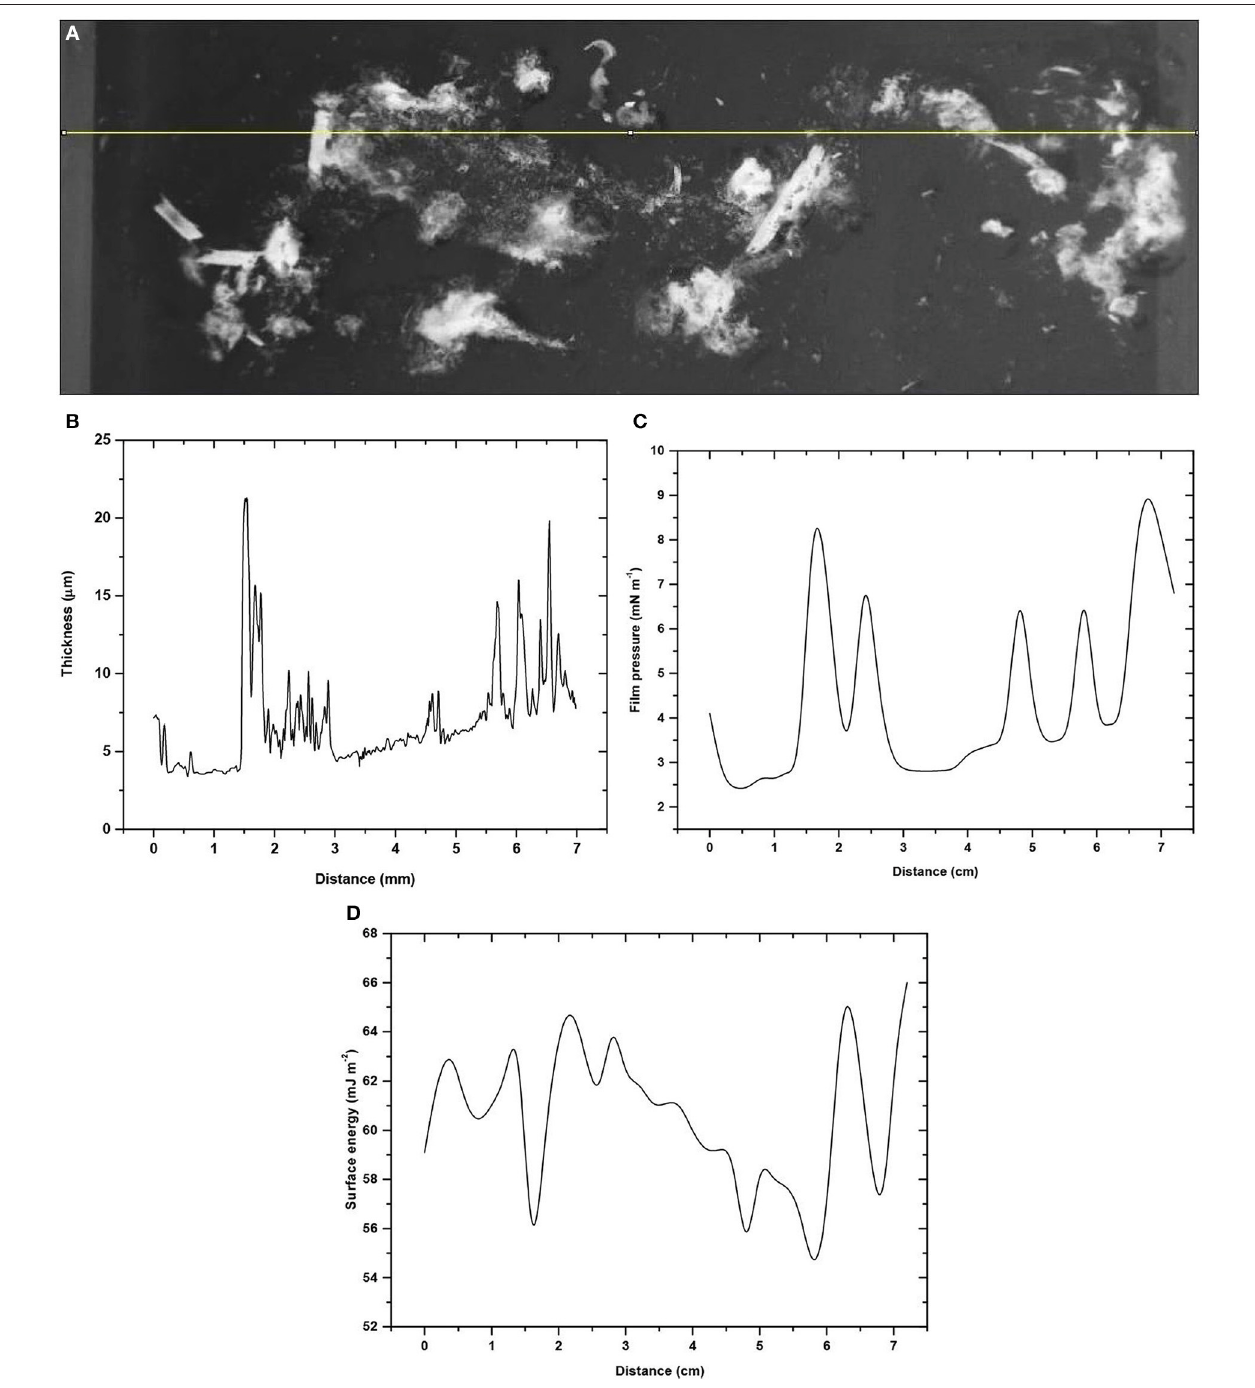
FIGURE 7 | Spatial mapping of marine biofilm heterogeneity on glass. (A) Optical profile along a horizontal line. (B) Biofilm thickness profile from confocal microscopy. (C) Surface pressure and (D) Surface energy profiles both derived with the wettability captive bubble sensor. factors like seasonal, local and biological activity in seawater